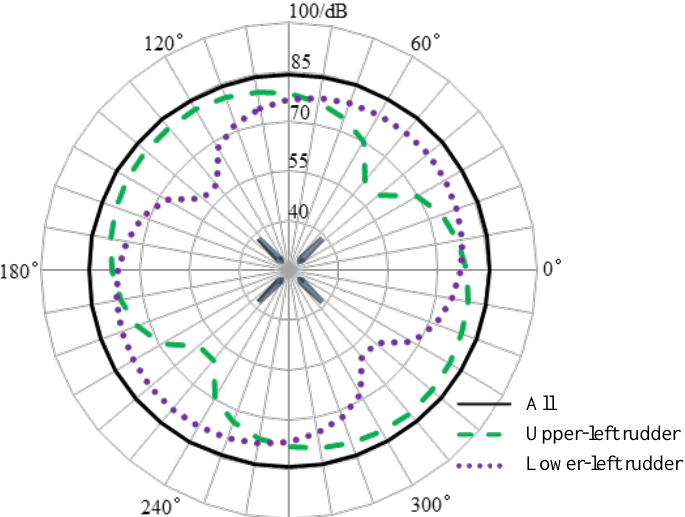
Figure 23. Directivity of sound pressure levels of each rudder surface of the cross-type tail part.